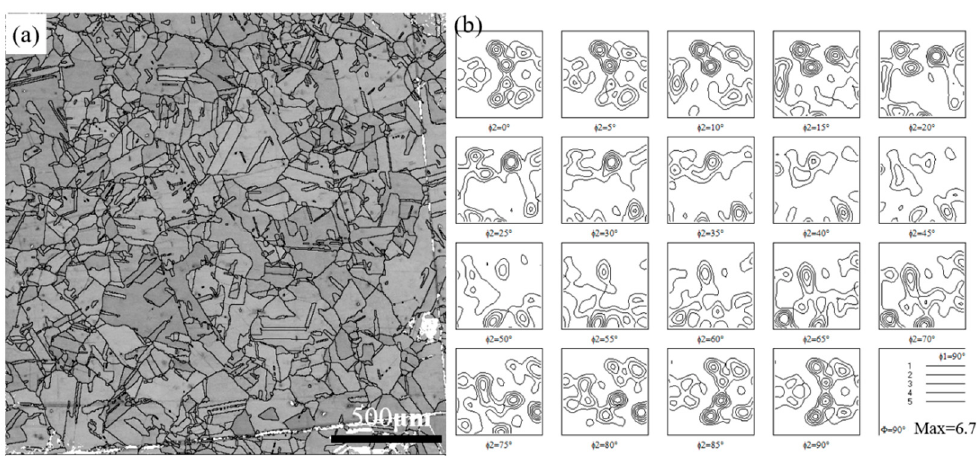
Figure 2. The as-received microstructure ( a ) and texture distribution ( b ) of ultra-high purity Cu-0.1Al alloy before rolling.